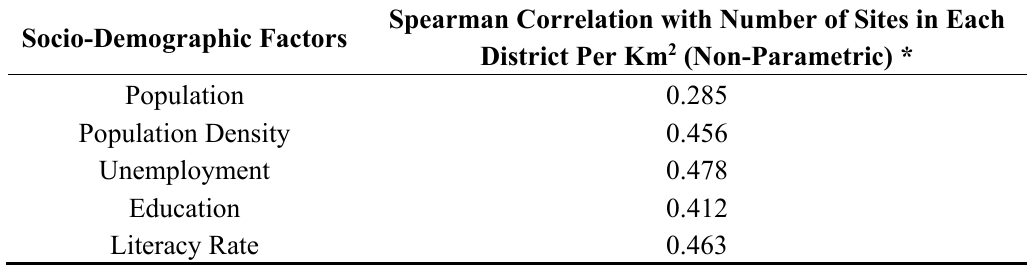
Table 4. Correlation